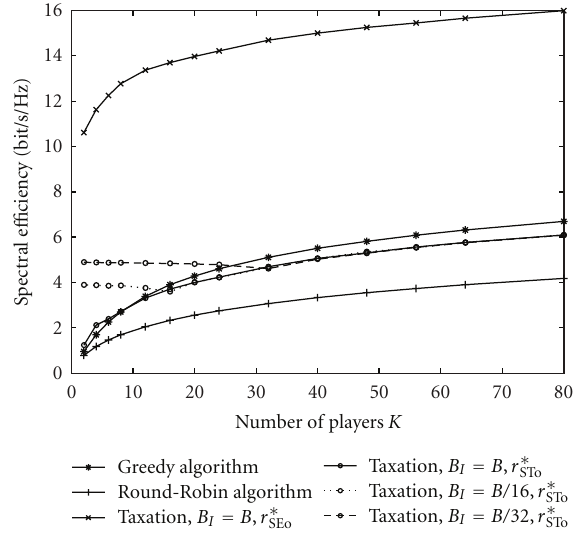
Figure 11: Spectral e ffi ciency for the optimal tax rate for both SelBM and SocBM; six-path channel